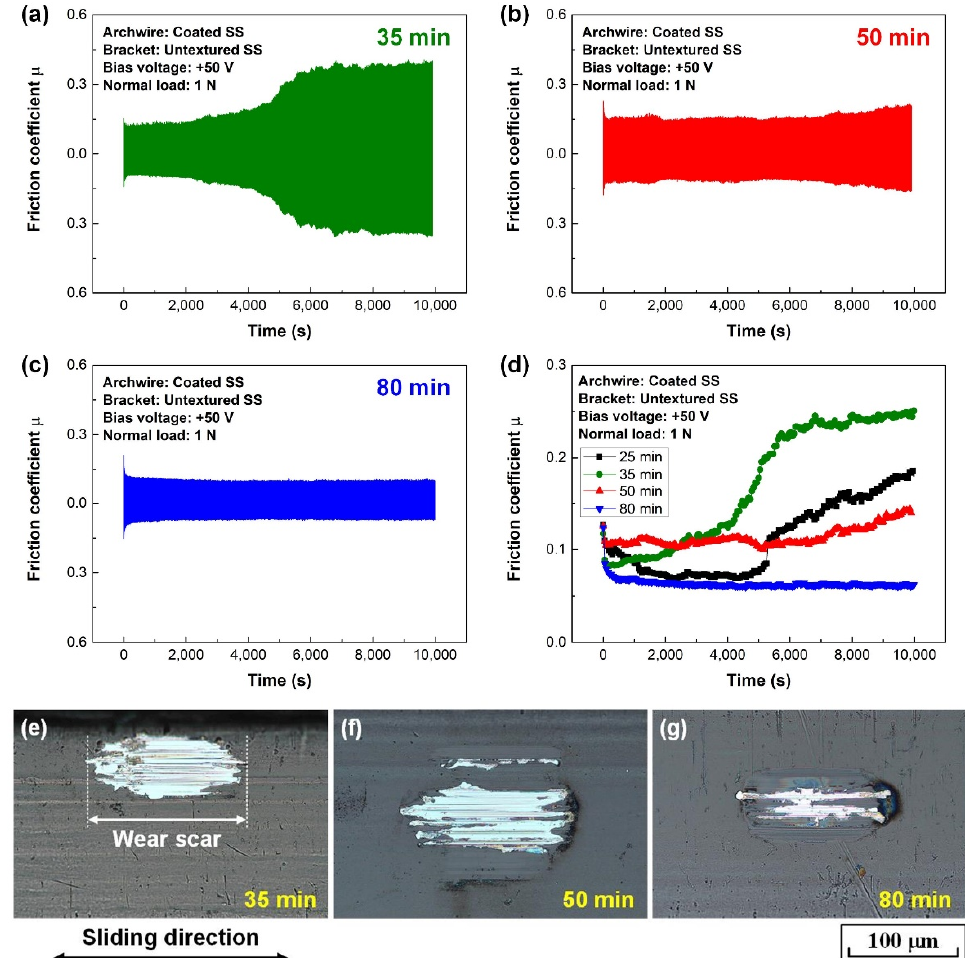
Figure 4. Fretting wear tests of different carbon film-coated stainless steel archwires running against conventional untextured brackets in artificial saliva environment. Friction curves of carbon films produced at the substrate bias voltage of +50 V and deposition times of ( a ) 35 min, ( b ) 50 min, and ( c ) 80 min. ( d ) Average friction coefficients of different carbon films. Optical microscopy images of the wear scars on carbon films with deposition times of ( e ) 35 min, ( f ) 50 min, and ( g ) 80 min.